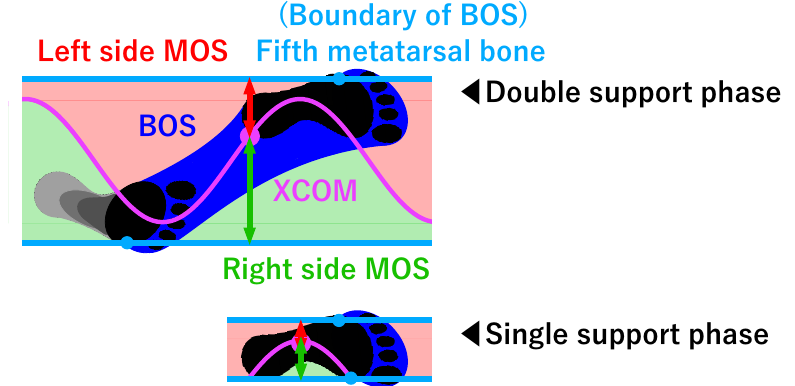
Figure 3. The BOS boundary was defined as the distance between the left and right Fifth metatarsal bones and the distance between the fifth metatarsal bone, and the first metatarsal bone for the double support phase, and the single support phase,